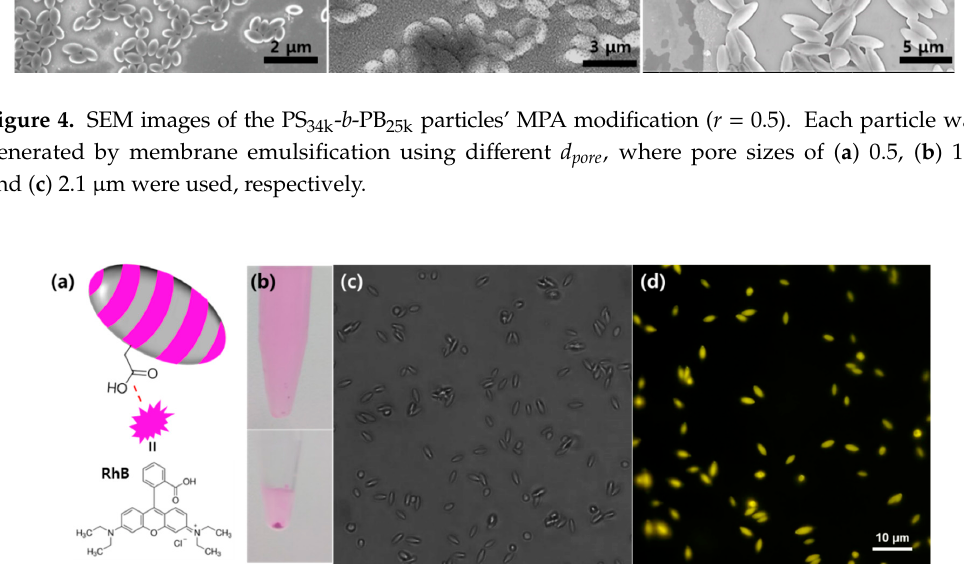
Figure 5. ( a ) Schematic showing the complexation of rhodamine B dye on the acid-functional surface of MPA-modified PS 34k - b -PB 25k particles ( d pore = 2.1 μ m); ( b ) photograph of the dye-complexed particle before the (upper) and after the (bottom) centrifugation; ( c ) optical microscope; and ( d ) the fluorescent microscopic image of rhodamine B functionalized ellipsoidal particles.